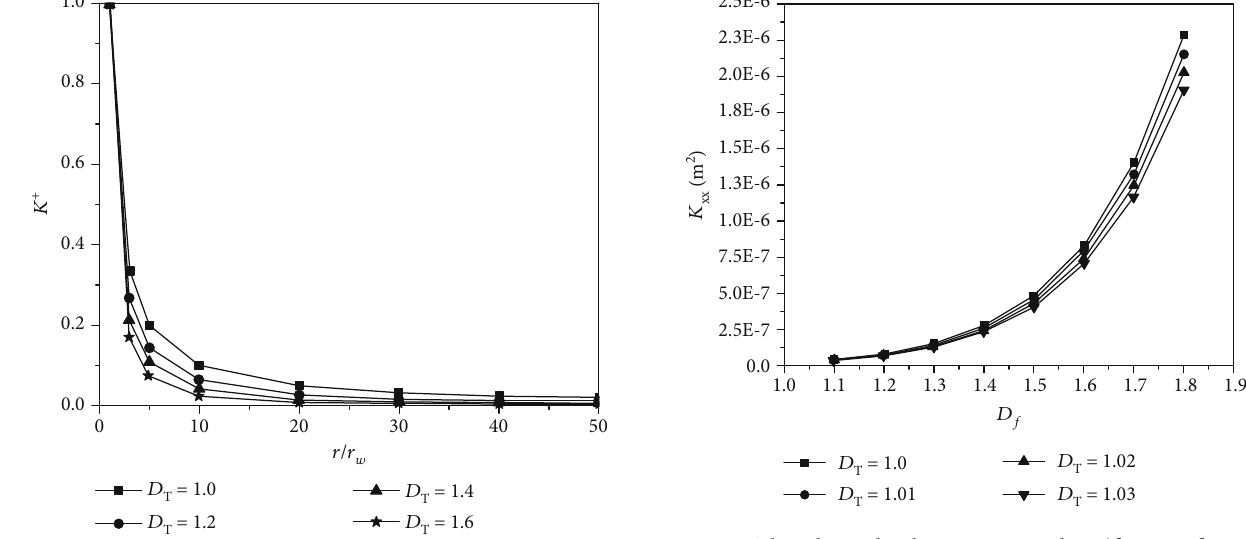
Figure 3: The relationship between K + and r / r